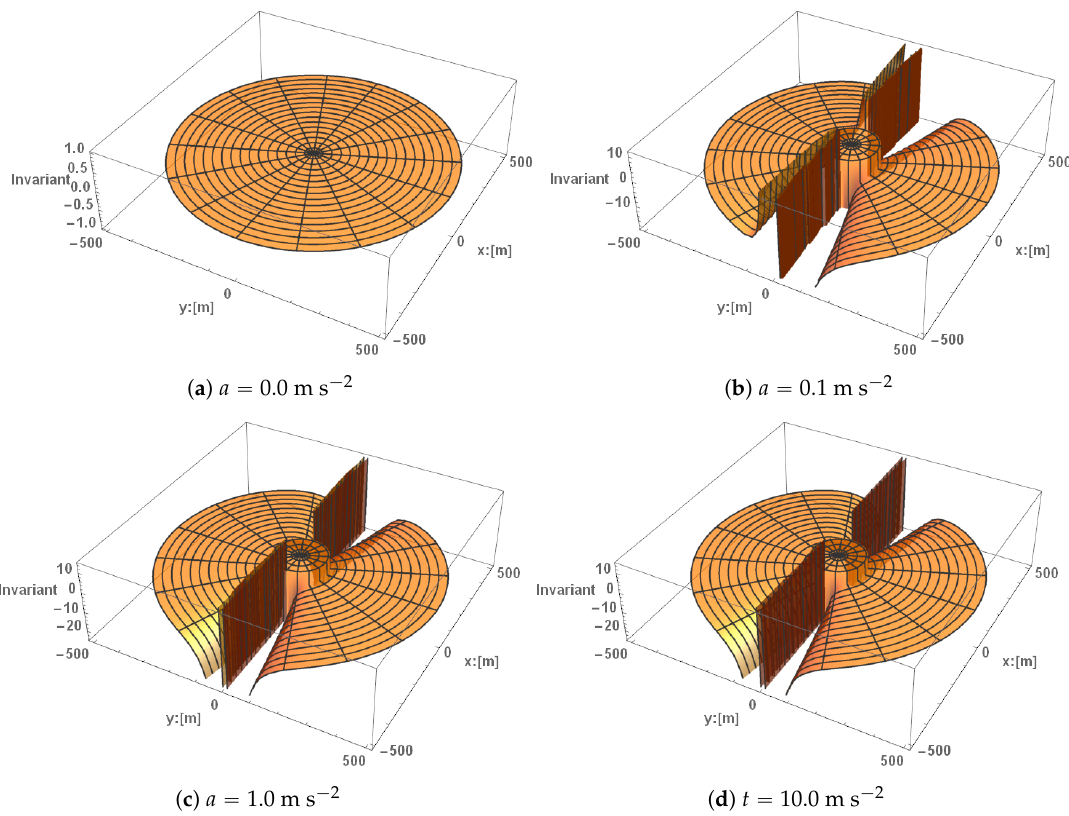
Figure 2. The acceleration, a , of the Ricci Scalar R is plotted in the figures above. The other parameters were set to be σ “ 50,000 m ´ 1 , ρ “ 100 m, and t “ 1 s. The plots were rendered using Mathematica’s ® RevolutionPlot3D. It plots a function by rotating the function around the z-axis. The amount that the space diverges from being flat is represented by the invariant function’s magnitude, and its amount is labeled on the vertical axis. The x and y-axis are displayed on the plots, and they display the distance from a spaceship in the flat portion at the center of each figure. Each radial line in the plot corresponds to a distance of approximately 33 m. The portion of small negative curvature to the right of the harbor is to the front of the warp bubble, and the portion to the left of the harbor is the back of the warp bubble. 4.3. Invariant Plots While Varying the Skin Depth of the Warp Bubble Varying the skin depth of the warp bubble, σ , does not noticeably affect the invariant